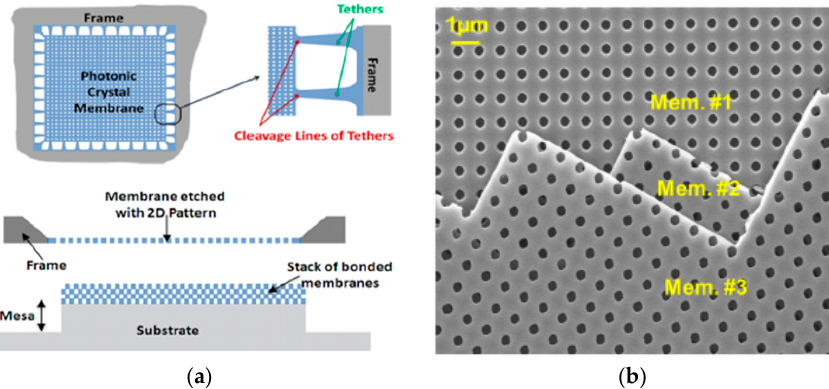
Figure 3. ( a ) Schematic of the membrane stacking approach using the cleavage of tethers from the frame. Reprinted with permission from [55]. Copyright [2011], American Vacuum Society; ( b ) SEM image of a stack of three silicon membranes. Reprinted with permission from [57]. Copyright [2011], American Vacuum Society.